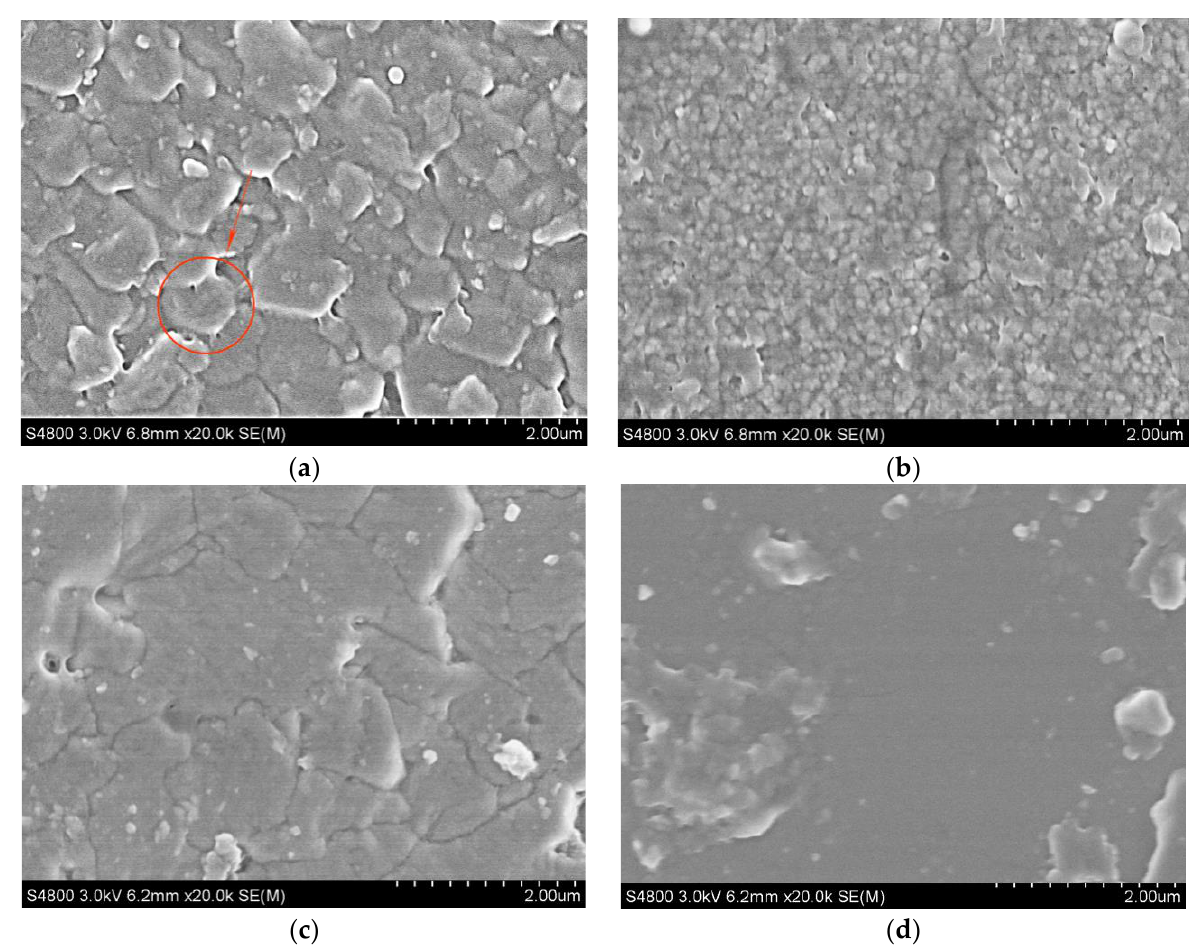
Figure 8. Inner surface state of scallop – shell interface under different experimental conditions. ( a ) Untreated; ( b ) 100 MPa; ( c ) 200 MPa; ( d ) 300 MPa.